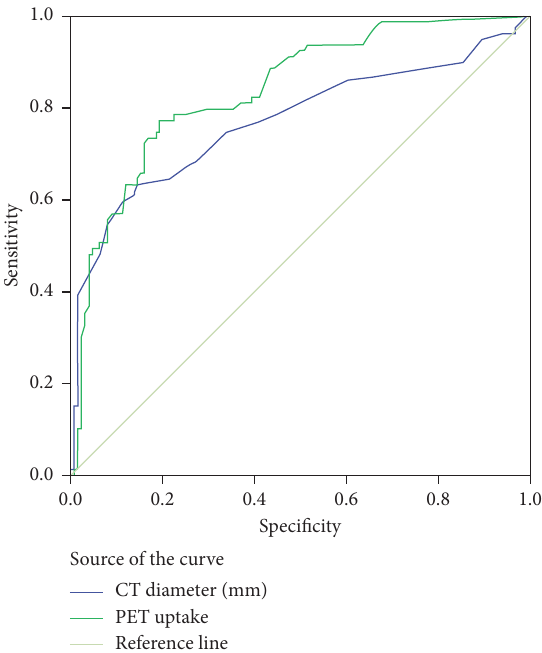
Figure 1: ROC curves. Diagonal segments are produced by